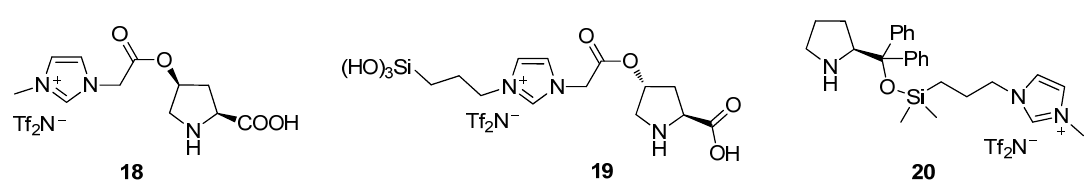
Figure 4. Different kinds of ionic liquid immobilized